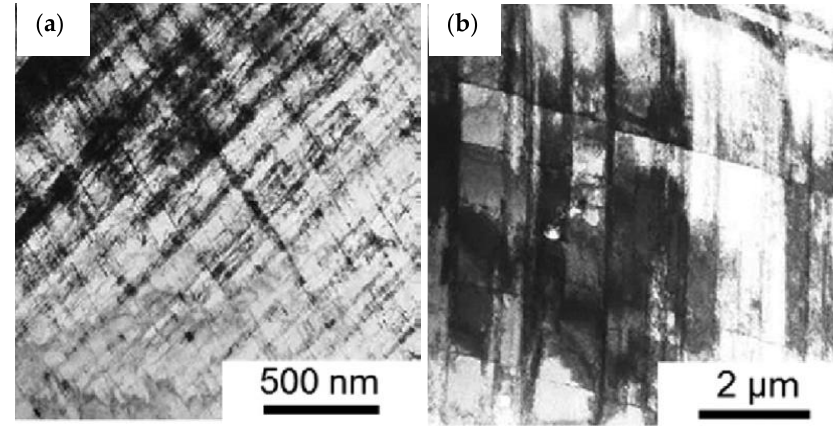
Figure 5. Slip distribution of ( a ) as-solutionized; ( b ) 16-h 550 °C aged Fe-29.8Mn-7.56Al-1.1C steels after 20% deformation. The reduction of ductility is related to the increased separation between slip bands due to the increased volume fraction and size of κ-carbides after aging [7].